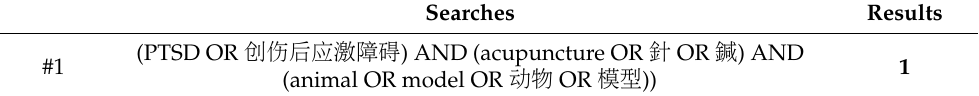
Table A15. CiNii.